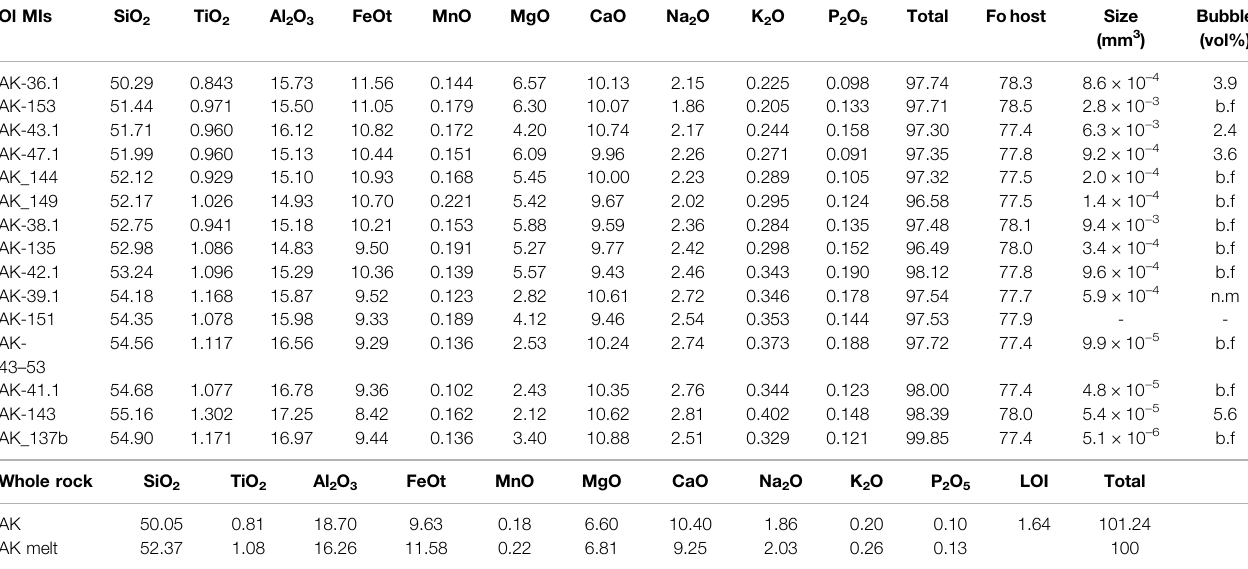
TABLE2| UncorrectedMImajorelementcompositionsfromEPMAandmajorelementwholerockcompositionsfromtheAKsampleinwt%.AKmeltfractionwascalculated with mass balance, using the mineral compositions and abundances measured in the thin section. Forsterite composition of olivine-hosts calculated from the EPMA olivine analyses. MI and bubble sizes were estimated by using the measured diameters.